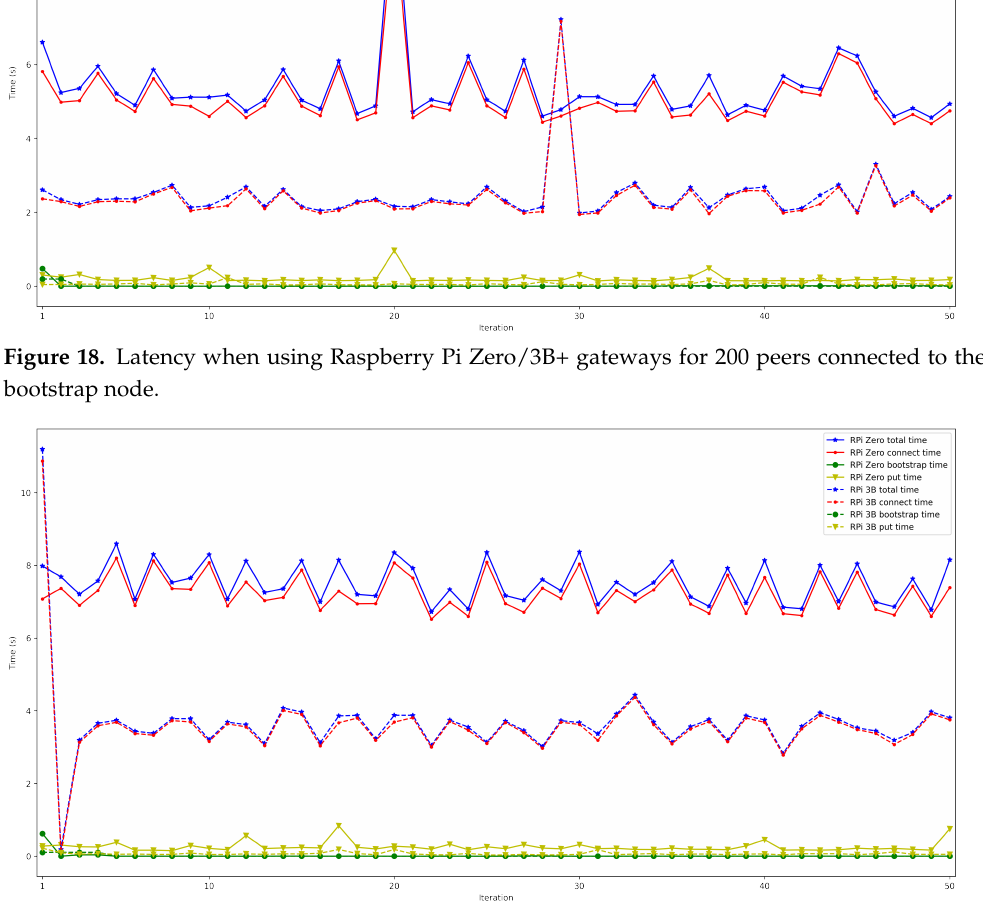
Figure 19. Latency when using Raspberry Pi Zero/3B+ gateways for 300 peers connected to the bootstrap node.